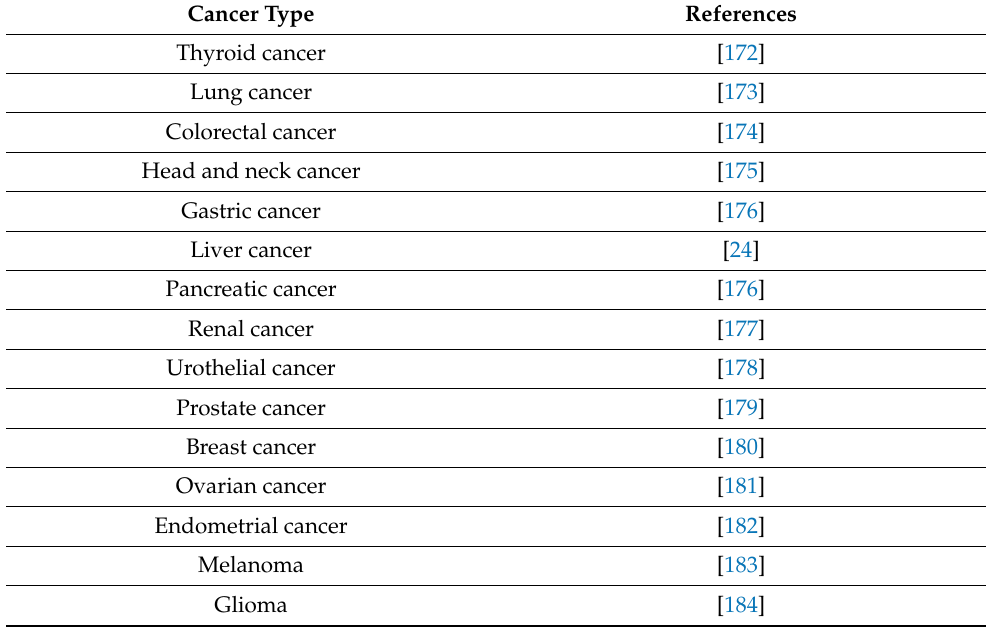
Table 1. Human cancers with overexpression of p62